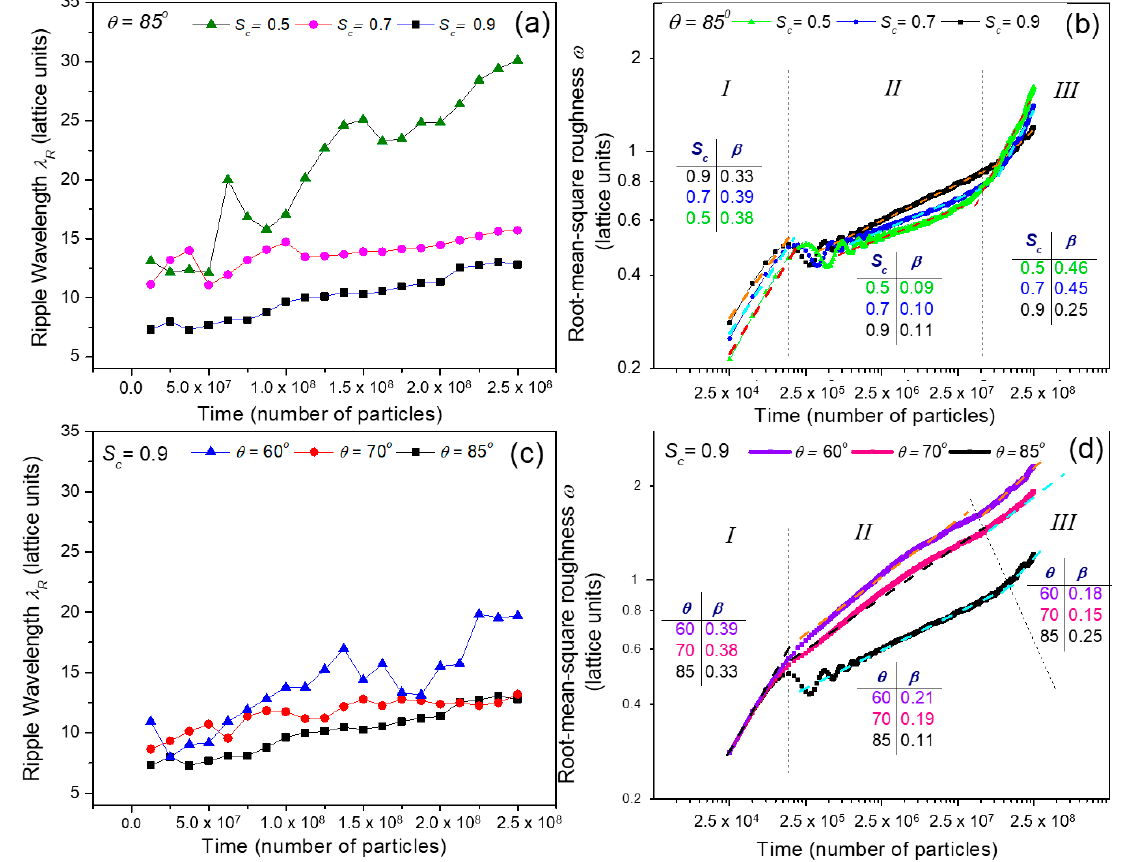
Figure 4. Dynamic evolution of ripple wavelength λ R ( a ) and RMS roughness ω ( b ) for di ff erent sticking coe ffi cients S c = 0.5, 0.7, 0.9 at an etching angle of θ = 85 ◦ ; and dynamic evolution of ripple wavelength λ R ( c ) and RMS roughness ω ( d ) for di ff erent etching angles θ = 60 ◦ , 70 ◦ , 85 ◦ .